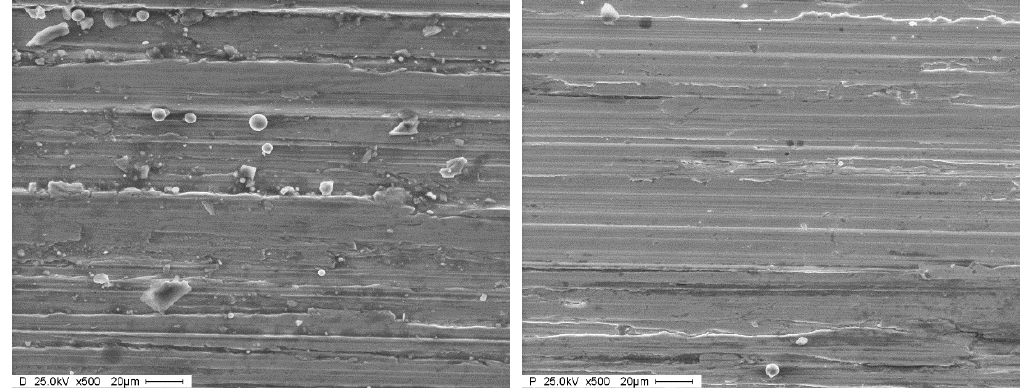
Figure 10. SEM images of cut surface with DE1 disc ( left ) and PE3 disc ( right ).